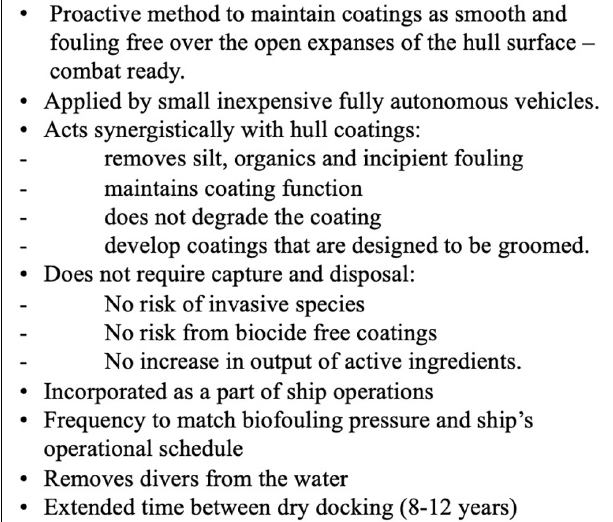
FIGURE 2 | Concepts for the development of a fully autonomous ship hull grooming vehicle (Swain et al., 2020).